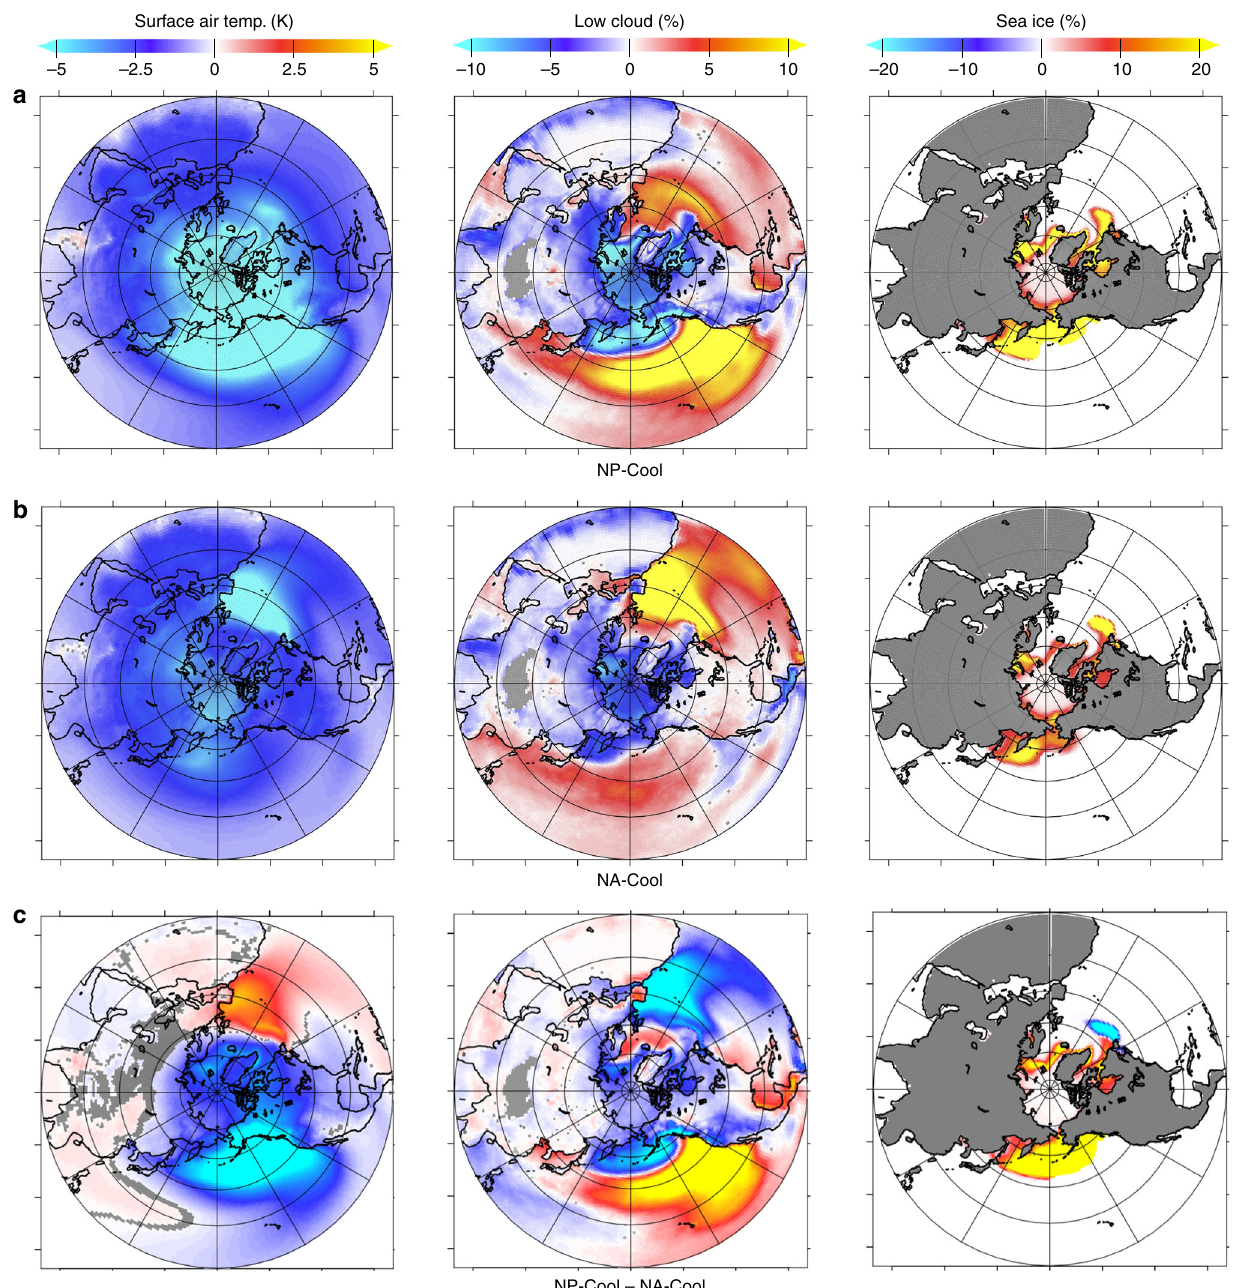
Fig. 4 Surface air temperature, vertically integrated low cloud, and sea-ice anomalies for the cool ocean simulations. Simulations for a cool North Paci fi c (NP-Cool), b cool North Atlantic (NA-Cool), and c the difference of the two simulations (NP-Cool – NA-Cool). Gray areas indicate changes not signi fi cant at the 95% con fi dence